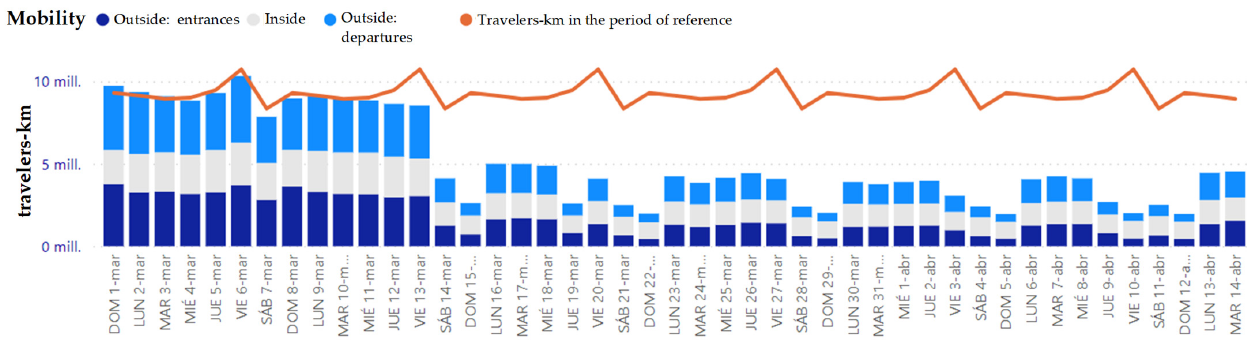
Figure 5. Evolution of daily mobility using public transport in Cartagena from the entry into force of mobility restrictions in 2020 (in blue) compared to the previous year 2019 (in red). Data source: Ministry of Transport of Spain and Cartagena City Council.